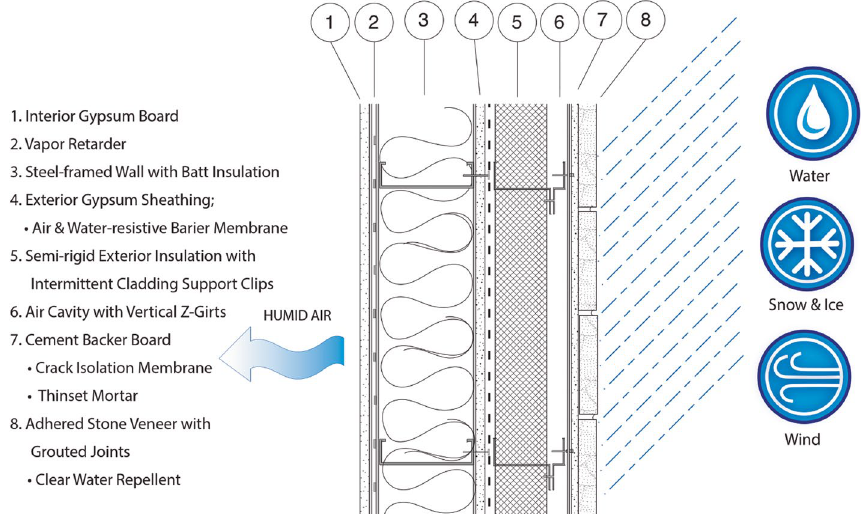
Fig. 7 Typical steel-framed rainscreen wall section with stone veneer cladding. Integrity of wall can be compromised by rain, snow and ice, and wind causing failure of cladding and moisture barrier systems and introducing humid air into interior rooms. Moisture and humidity control are critical for conservation of art objects. (Source: the